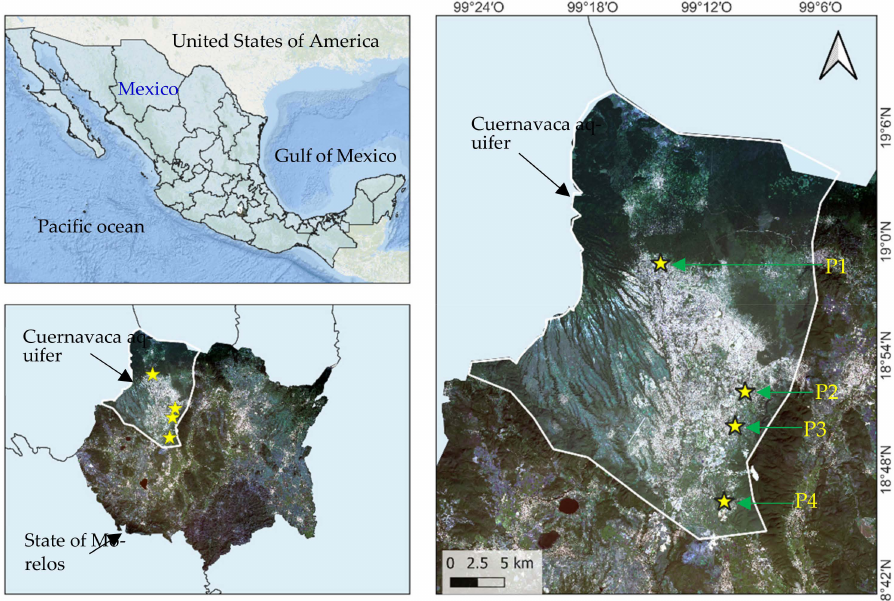
Figure 1. Location of the Cuernavaca aquifer and location of sampling